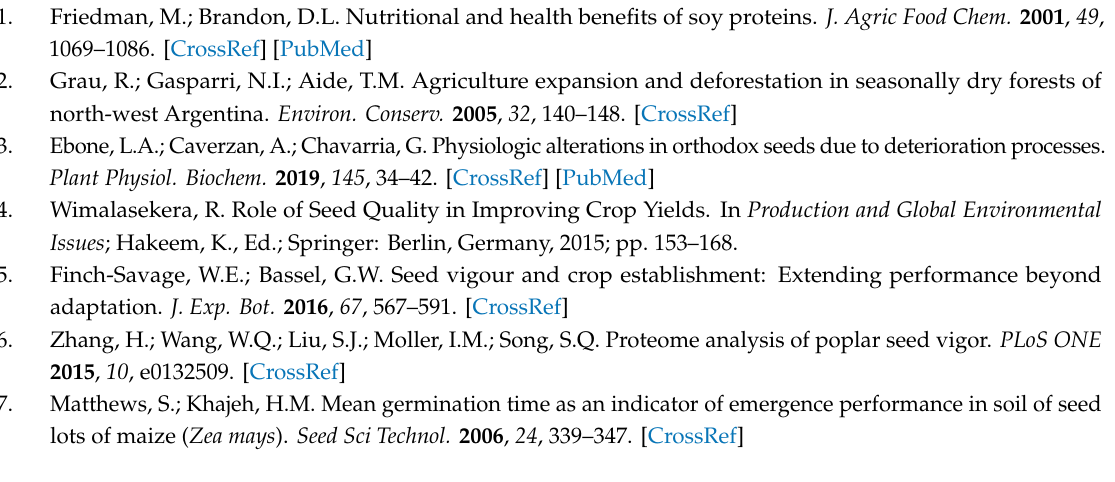
Figure S1: Water soil content. Volume moisture (m3 / m3) at Field Capacity (Vm FC) and Permanent Wilting Point (Vm PWP) in di ff erent soil depth (0.00–0.20 m) at three sites (I, II and III), Figure S2: Plot design. Schematic representation of each plot (7m × 14 rows), with 2 rows and 1 m of each side as borders control to plants with emergence days after sowing (EDAS) evaluated in the five rows of 1.35 m located in the third and twelfth sowing row. Table S1: Chemical analysis of the soils of the three sites (I, II and